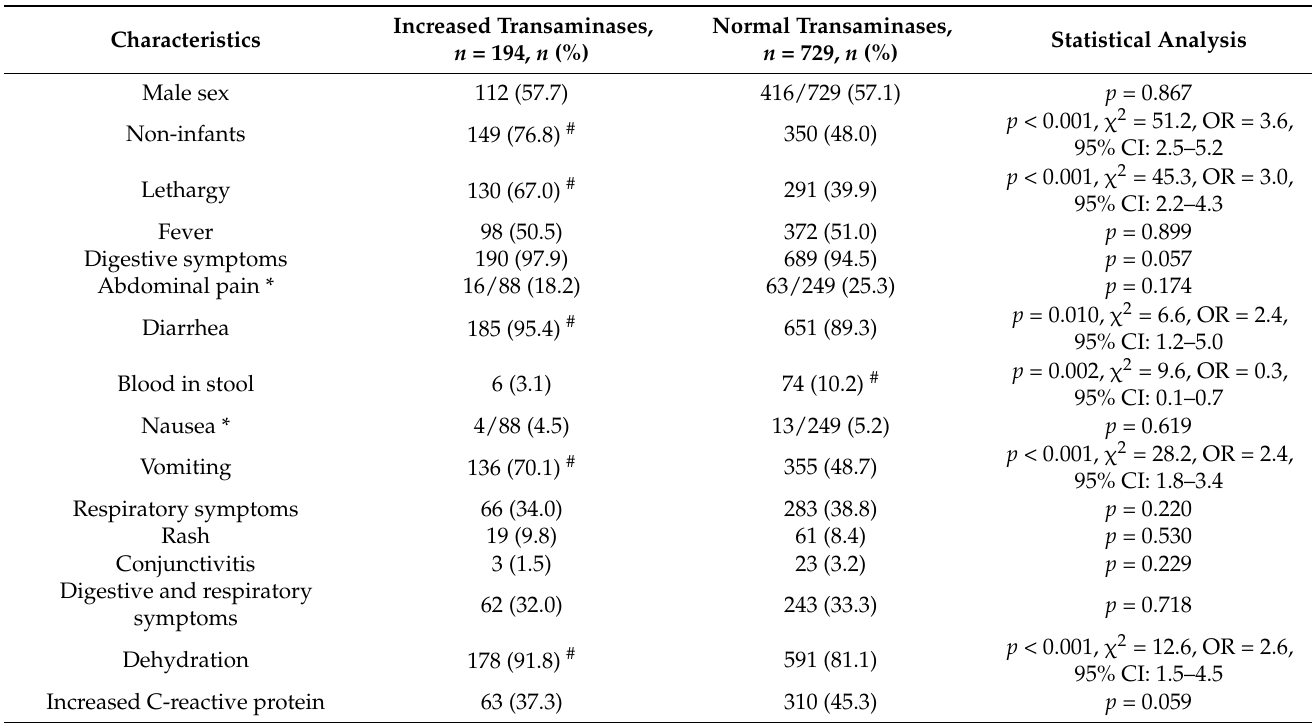
Table 4. Comparative analysis in relation to transaminase increase after exclusion of patients with chronic conditions and co-infections.